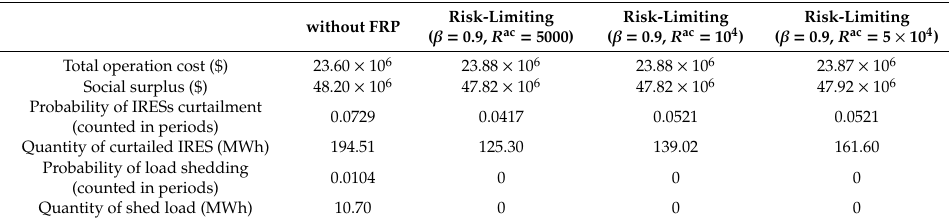
Table 6. Simulation results with and without